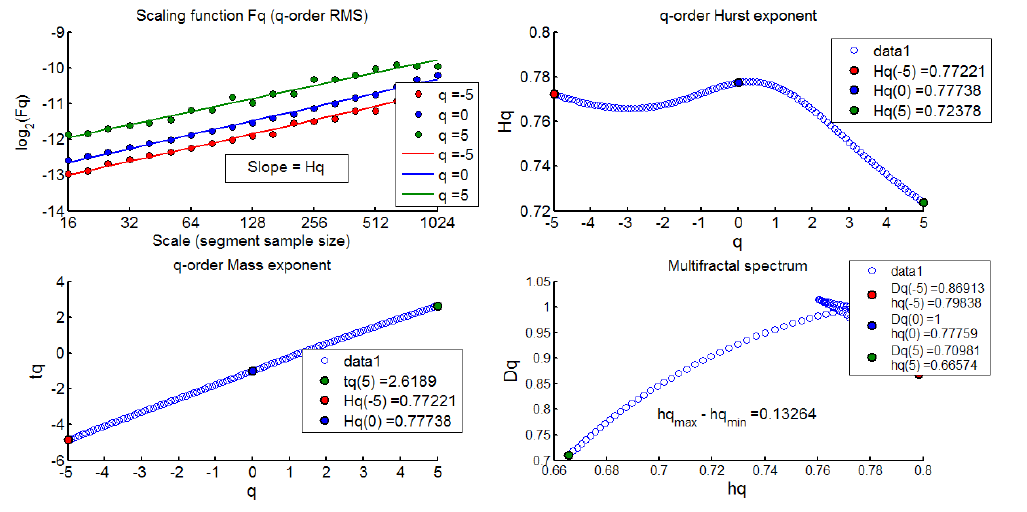
(5) of Nifty Pharma index on June 16, 2020, i.e., ( t = 0) Figure 8. The H q